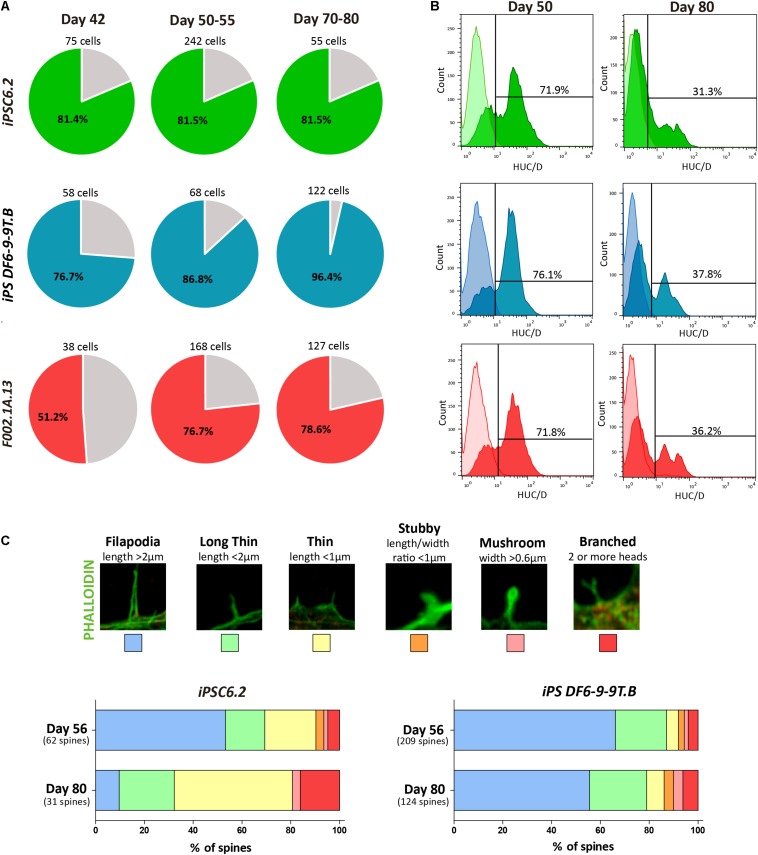
Assessment of neuronal maturation. (A) The percentage of responsive cells displaying a Histamine/KCl ratio below 0.8 is shown in colored slices. For each iPSC line three independent differentiation experiments were performed. (B) Flow cytometry analysis of HuC/D+ cells on days 50 and 80 of differentiation of the indicated iPSC lines. (C) Representative images of dendritic spine morphologies. Bars depict the relative proportion of the distinct dendritic spine morphologies observed in cultures derived from the indicated iPSC lines on days 56 and 80.